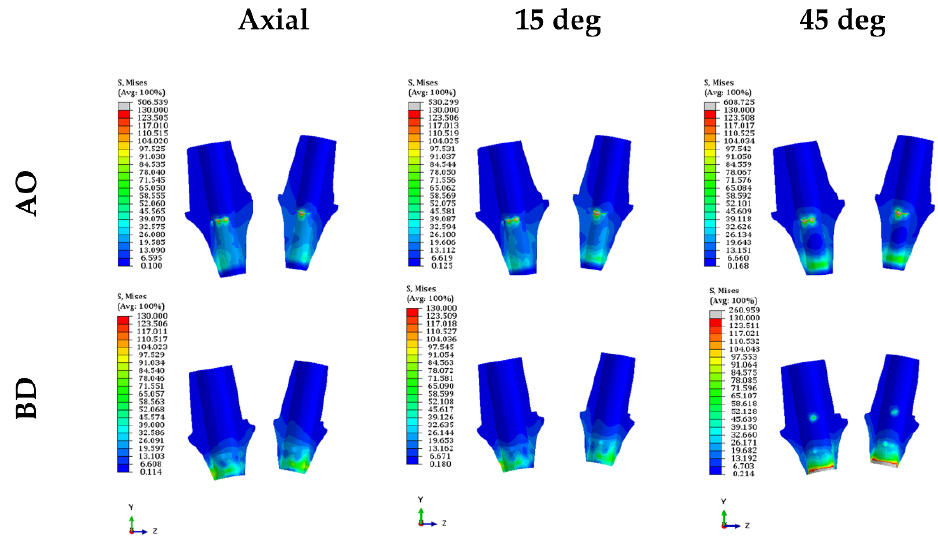
Figure 9. Mean stress distribution of the outer surface of the abutment and fixture in the second premolar and second molar.